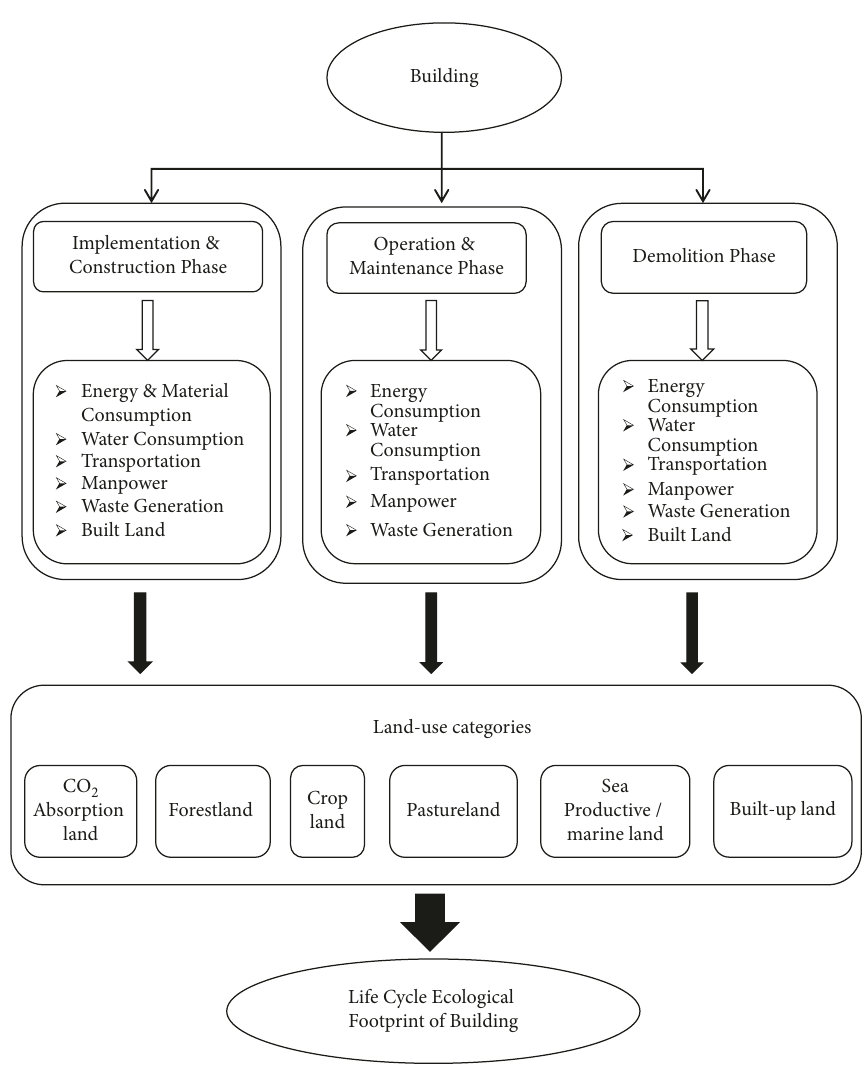
Figure 2: Flow diagram of the EF